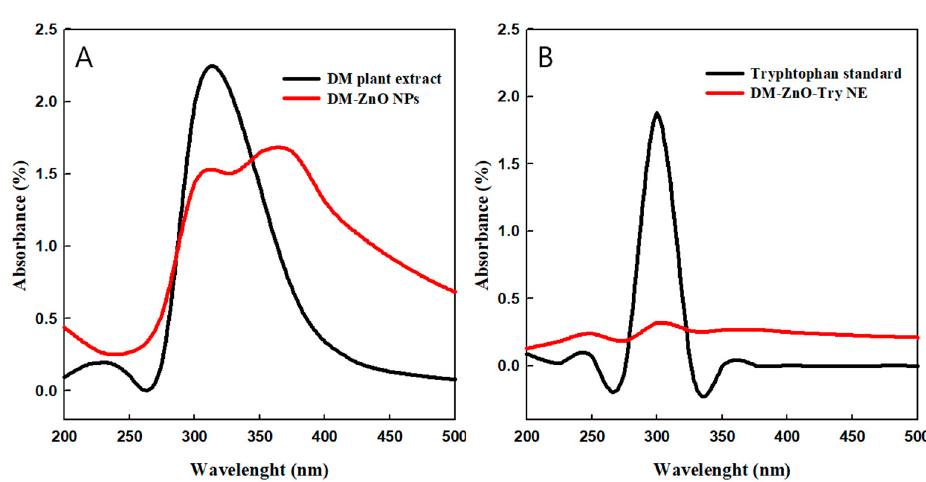
Figure 2. UV–Visible spectra of ( A ) DM-ZnO nanoparticles (NPs) with DM extract and ( B ) DM-ZnO-Try NE with standard tryptophan.